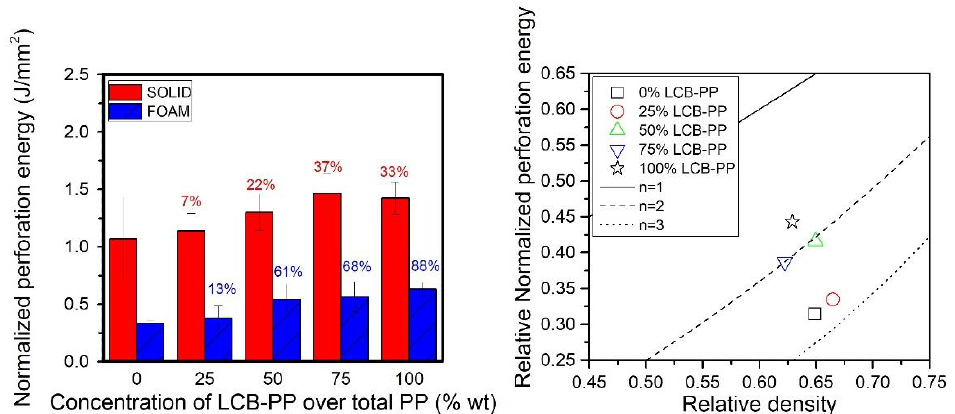
Figure 10. Instrumented falling weight impact (IFWI) normalized perforation energy of solids samples and foams ( left ) and relative IFWI normalized perforation energy of foams in the scale model representation ( right ). The percentages in the left graph indicate the percentage of improvement of this sample with respect to the 0% LCB-PP compound value, for solids ( red ) and foams ( blue ).